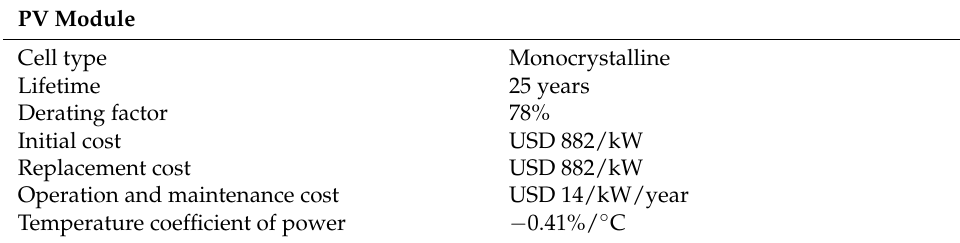
Table 2. Photovoltaic